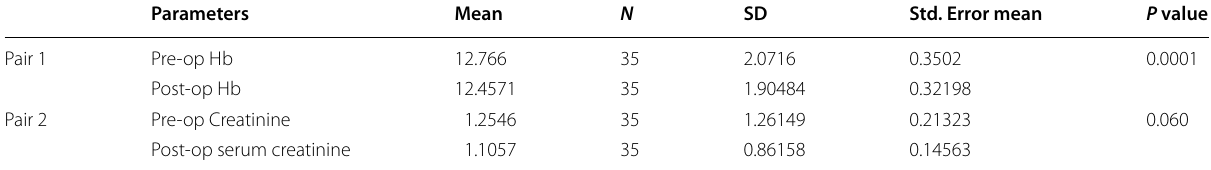
Table 4 Hemoglobin and creatinine levels of patient before and after surgery